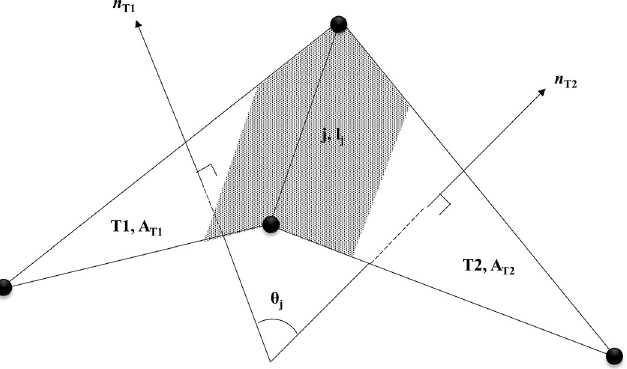
Fig 2. Illustration of M normal vectors to the triangles T 1 and T 2